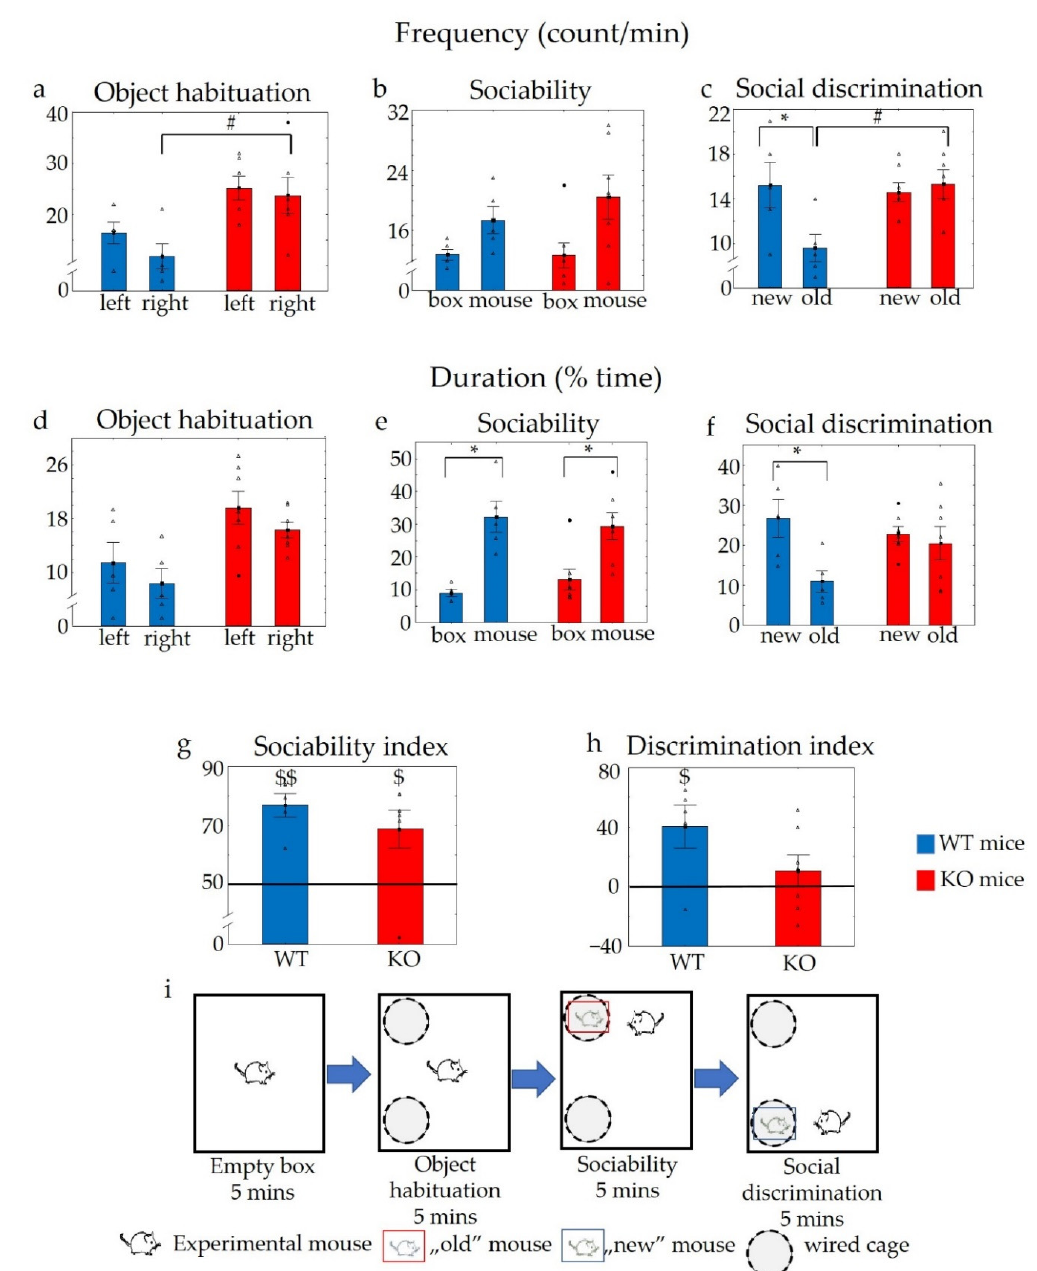
Figure 8. Results of the sociability test. During the object habituation phase, the KO animals investigated the objects more times than the WTs ( a ), but the difference in the duration was not significant ( d ). During the sociability phase, increased interest was detected towards the social stimulus in both groups without significant genotype differences ( b , e ). During the social discrimination phase, WT animals demonstrated increased interest towards the novel stimulus mice, but this kind of difference were not detectable in KO mice ( c , f ). Both genotypes revealed significant social interest as represented by a sociability index higher than 50% ( g ). However, only WTs showed intact short-term social memory as represented by a discrimination index higher than 0 ( h ). Schematic representation of the sociability trial ( i ). n = 5 in WT and n = 7 in KO groups, the symbol # shows a significant difference between KO and WT mice ( p < 0.05); * shows a significant difference between the two sides with wired cages, in cases with * p < 0.05; $ shows a significant difference in the same group using a single sample t-test, in cases with $ p < 0.05, and $$ p < 0.01. Blank triangles represent individual values while dark spots show outliers (characterized by a higher or lower value than mean ± 2 standard deviation